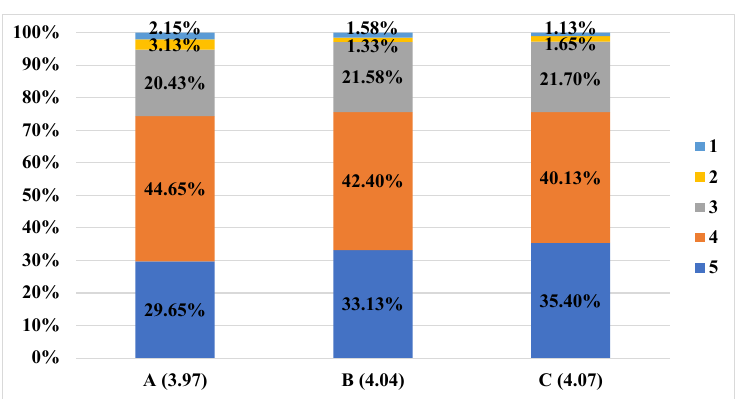
Figure 5. Results of the manual evaluation (Chinese →